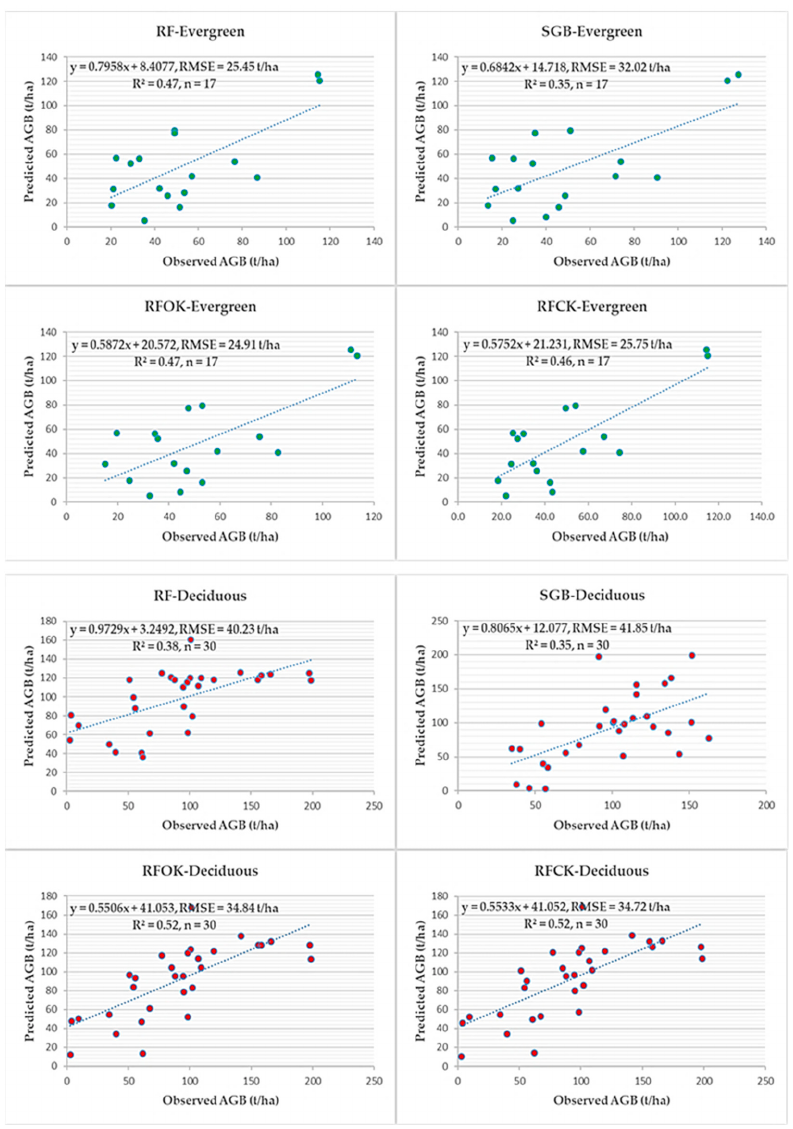
Figure 6 . The scatter plots for validation metrics of RF, SGB, RFOK, and RFCK models . Figure 6. The scatter plots for validation metrics of RF, SGB, RFOK, and RFCK